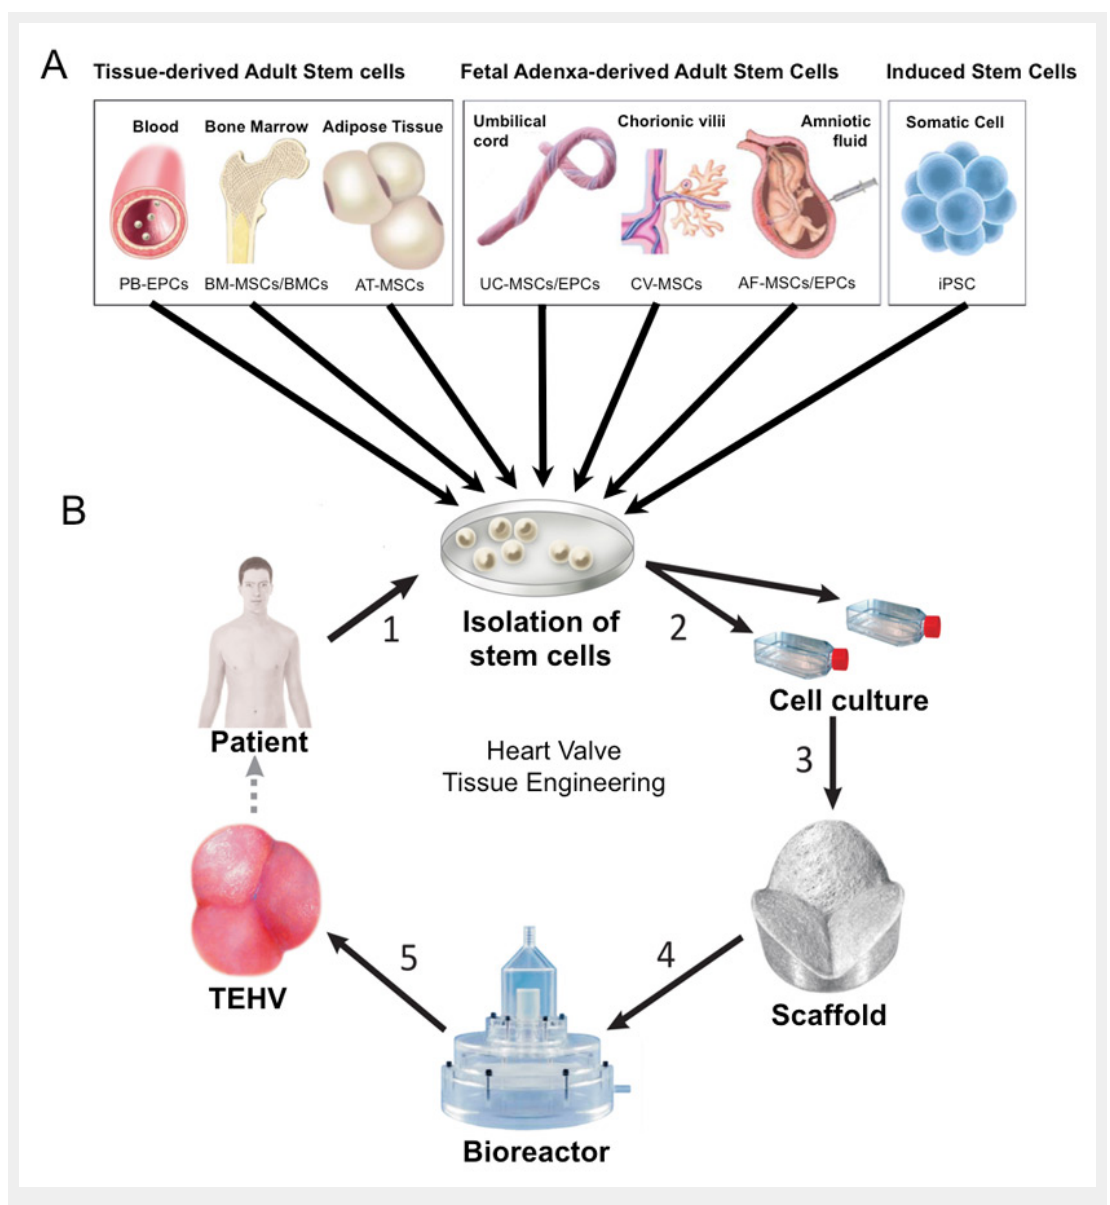
Available stem cells for heart valve tissue engineering. (A: Donor tissues and stem cell sources, B: Introduction of the cells into the in vitro heart valve tissue engineering procedure; 1: cell isolation, 2: cell expansion, 3: seeding of cells onto the scaffold, 4: dynamic conditioning of the construct in a bioreactor system, 5: possible implantation of the deriving construct into the